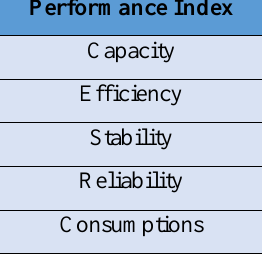
Figure Labels: Use 8-point Times New Roman for Figure labels. Use words rather than symbols or abbreviations when writing Figure axis labels to